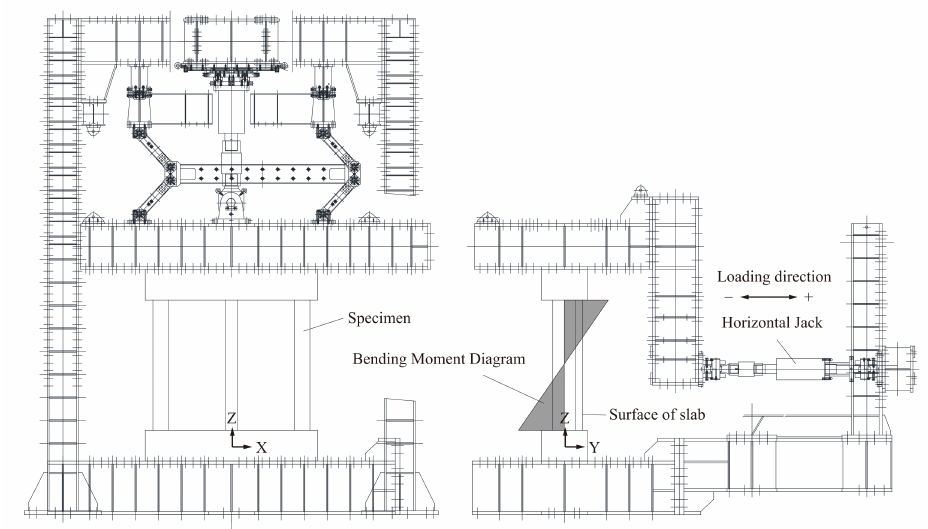
Figure 7. Schematic of the loading